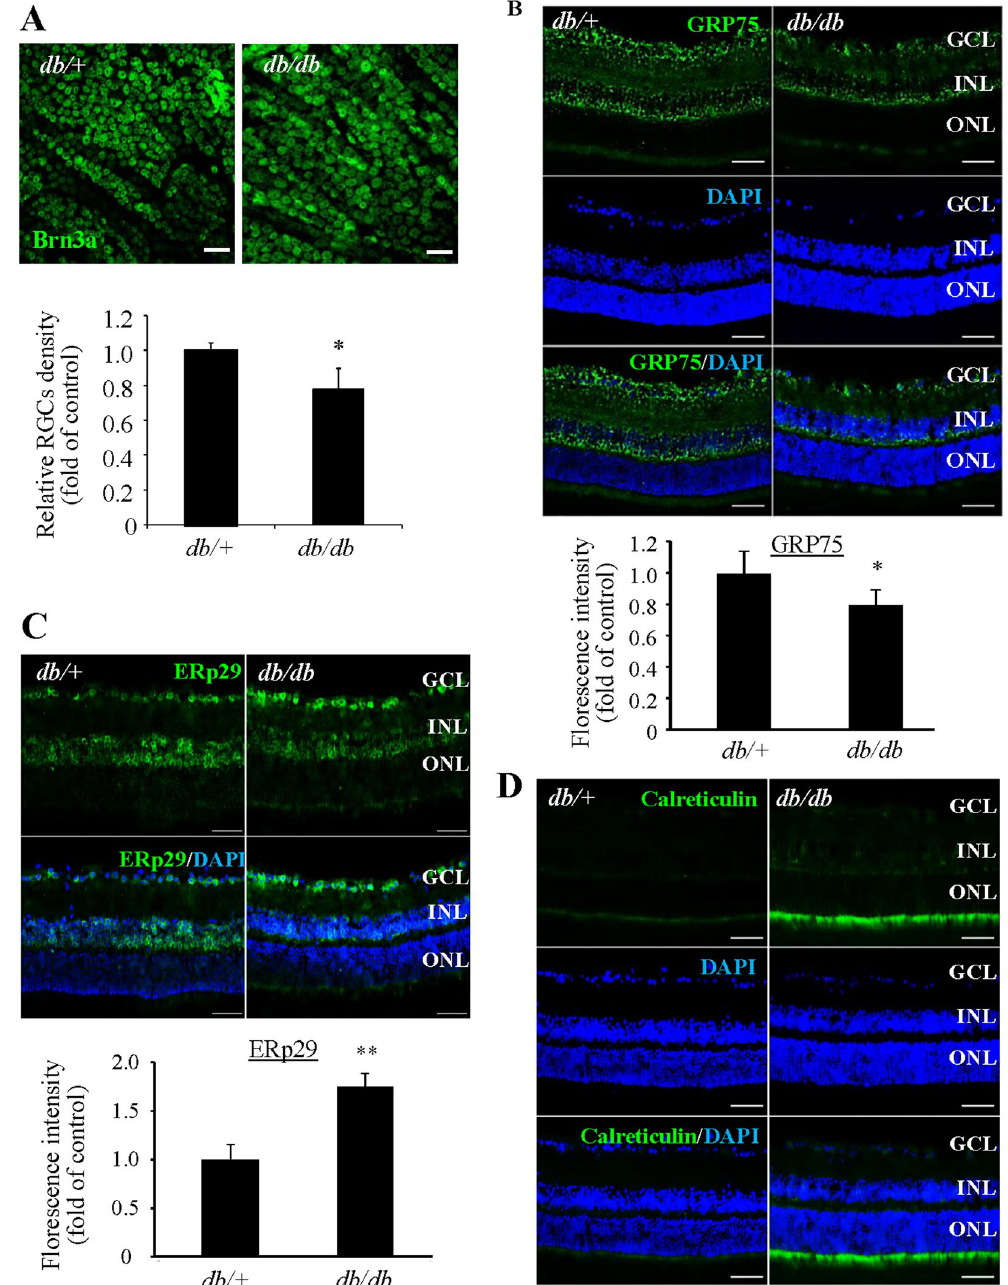
Figure 5. Loss of retinal ganglion cells and decreased retinal GRP75 expression in db/db mice. ( A ) Retinal whole mounts were stained for Brn3a to visualize the retinal ganglion cells (RGCs) and examined by confocal microscope. The density of RGCs was decreased in db/db mice. Scale bar = 50 μ m. Data were shown as mean ± SD, n = 3. * P < 0.05. Student’s t test. ( B–D ) Immunostaining showing decreased GRP75 ( B ), ERp29 ( C ), and calreticulin ( D ) in db/db mouse retinas and controls. Scale bar = 50 μ m for ( B–D ). Images represent results from 3 individual mice in each group. GCL: ganglion cell layer, INL: inner nuclear layer, ONL: outer nuclear layer. Fluorescence intensity was quantified by Image J software and expressed as fold of change relative to control (mean ± SD, n = 3). * P < 0.05. ** P < 0.01, Student’s t